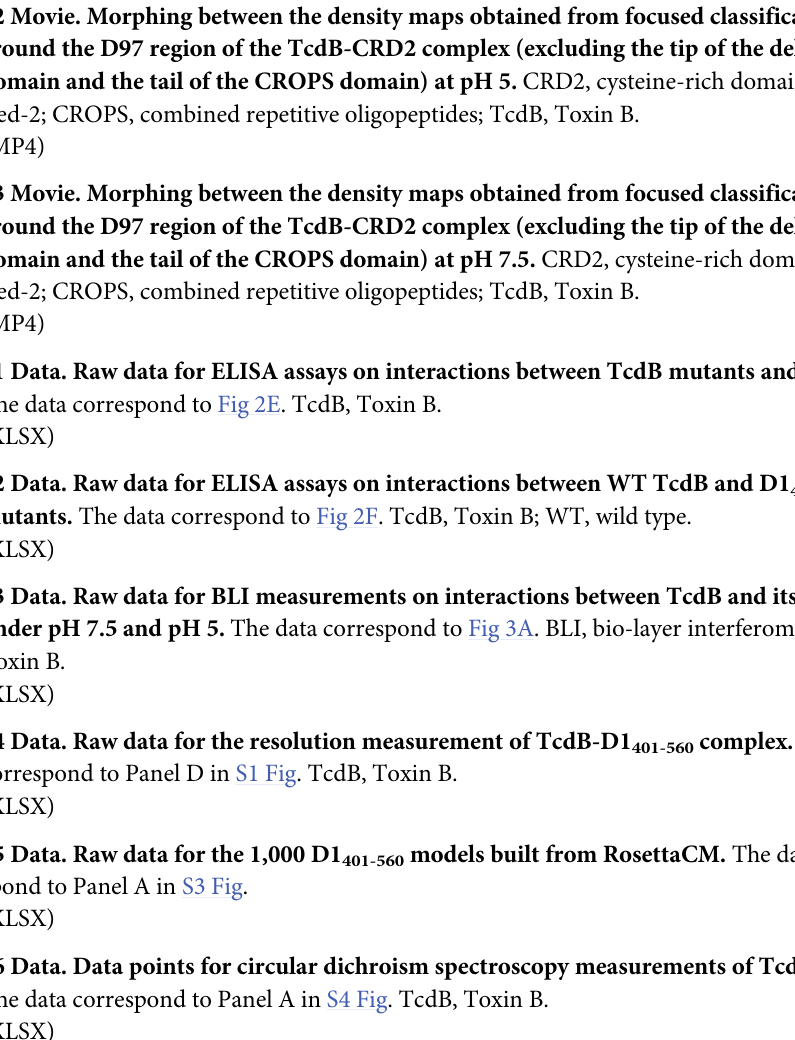
S1 Table. Primer sequences for amplifying each of the genes. (PNG) S2 Table. Primers used in the mutagenesis for D1 S3 Table. Data collection and data processing of the cryo-EM density